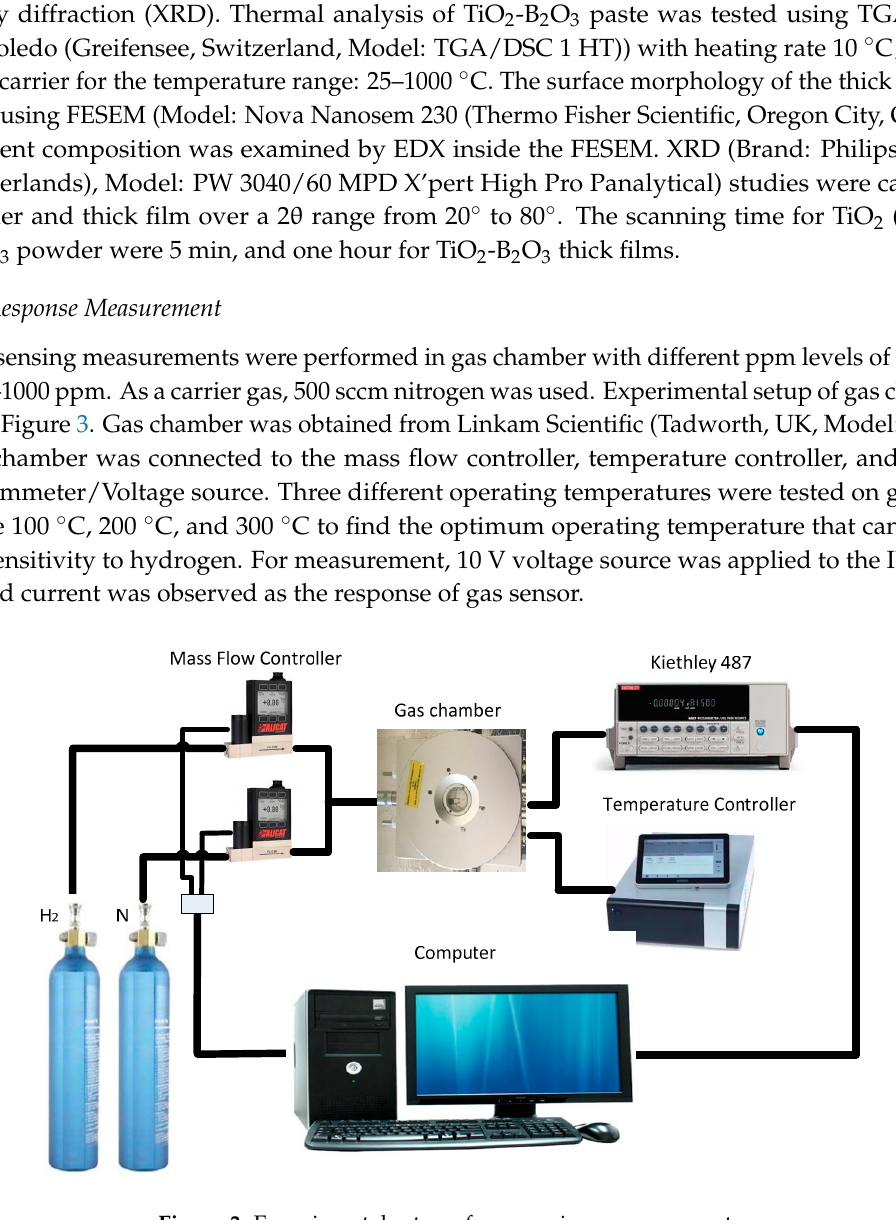
Figure 3. Experimental setup of gas sensing measurement.